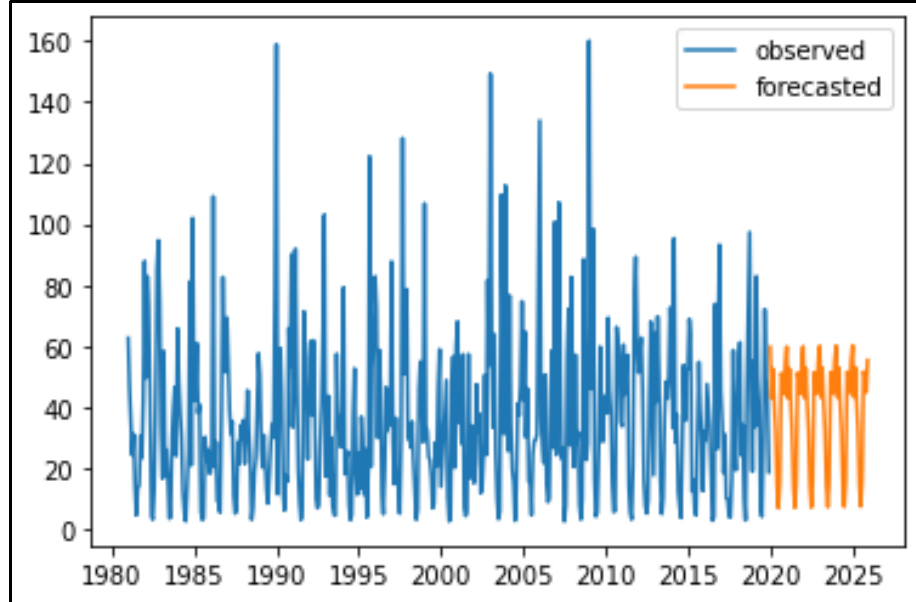
Figure 5. Rainfalls forecasting trend from 2020 to 2025.